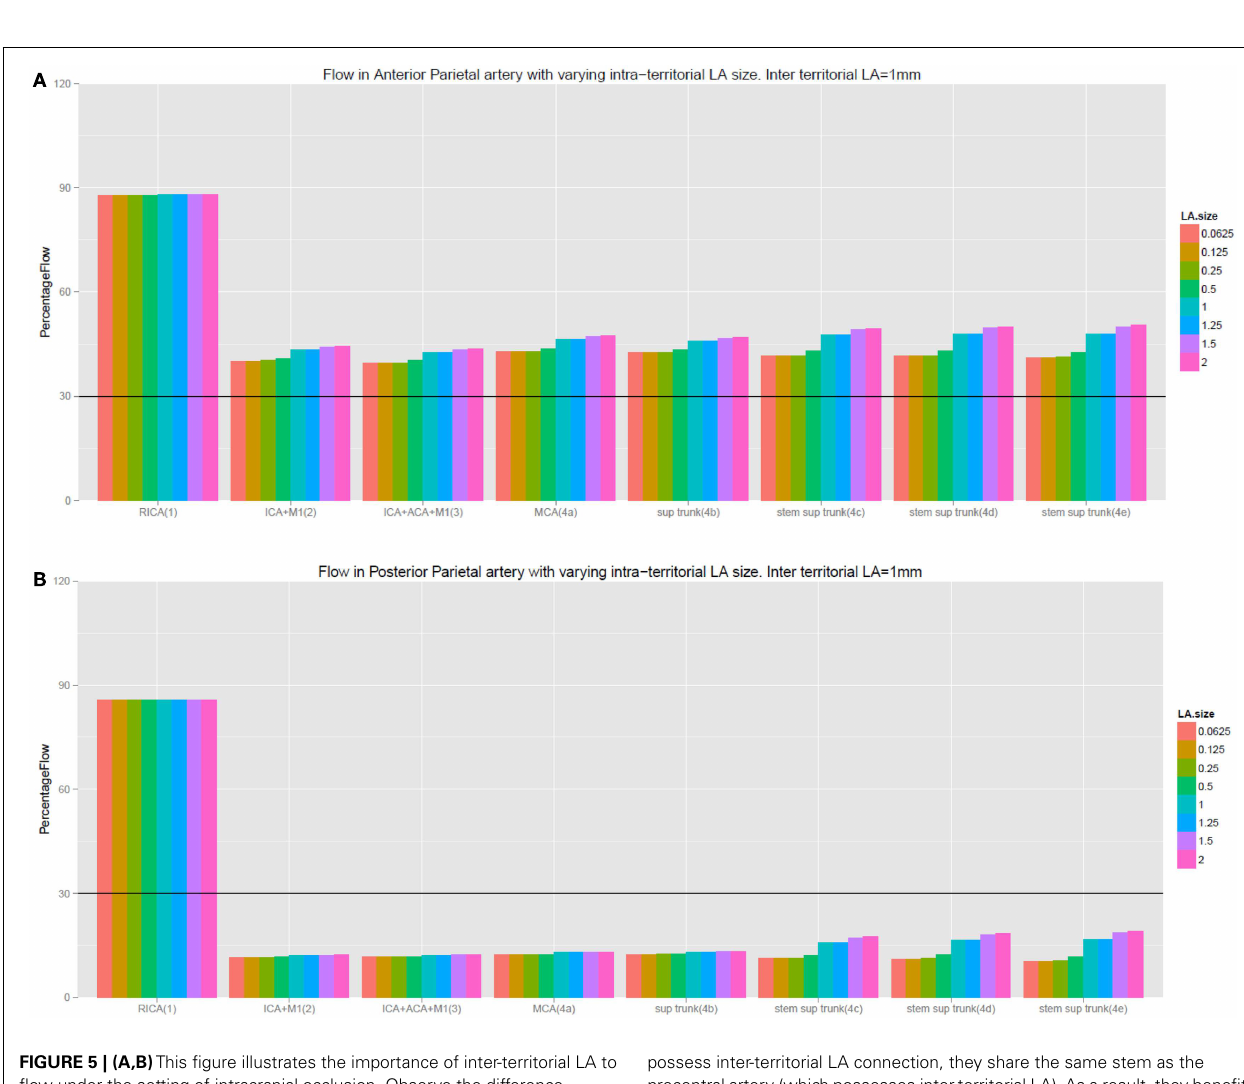
possess inter-territorial LA connection, they share the same stem as the precentral artery (which possesses inter-territorial LA).As a result, they benefit from backflow from the precentral artery when the inter-territorial LA is 1.0 in diameter.The labeling of the experiments remain the same as in the